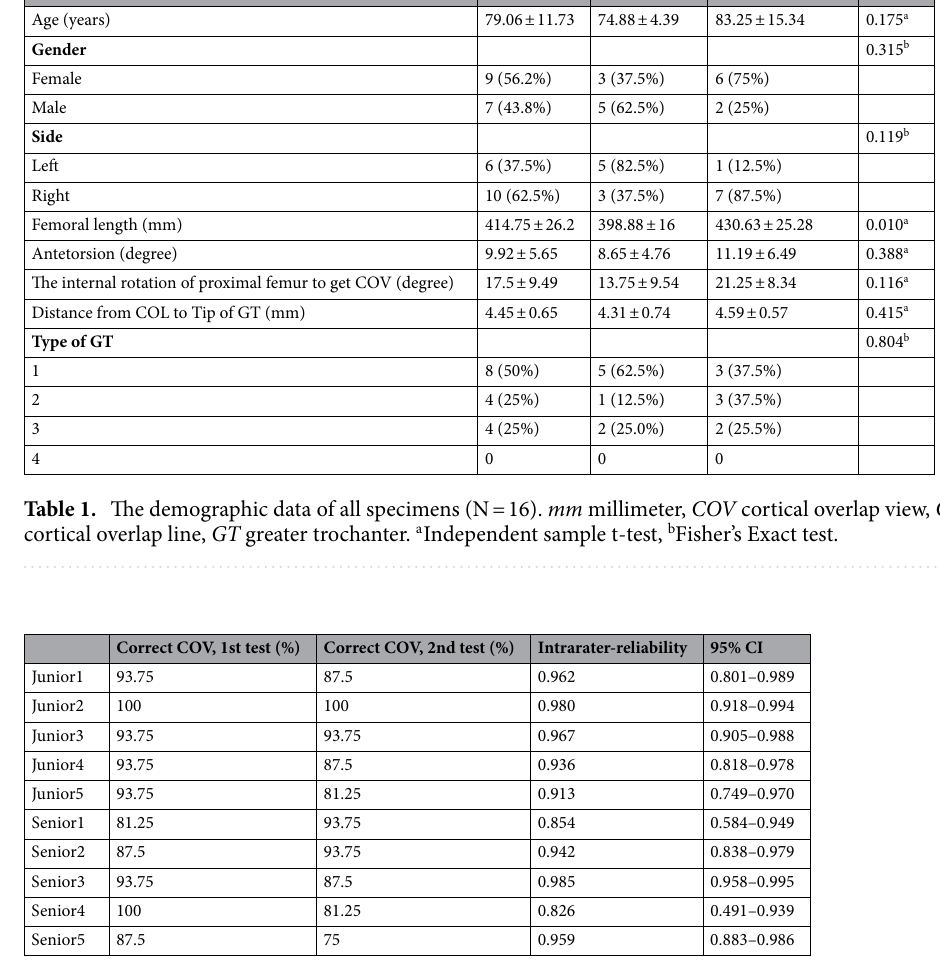
Table 2. Individual results of the 10